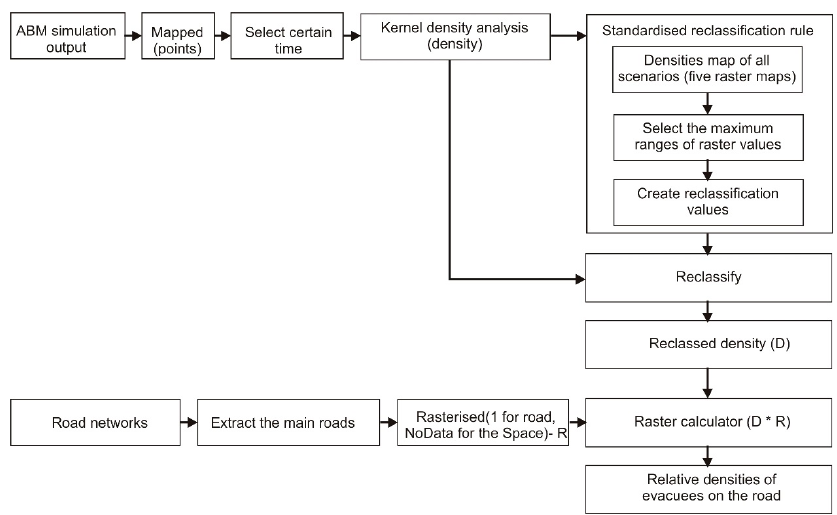
Figure 7. Relative density analysis of the evacuees’ traffic.